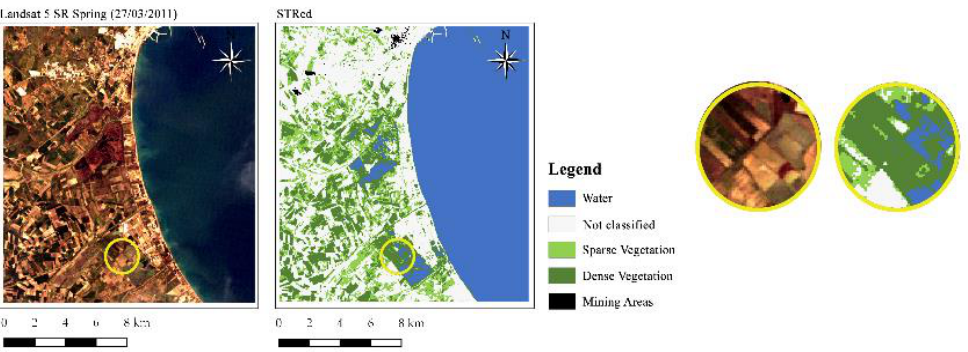
Figure 7. SwirTiRed index (STRed) classification outcome for Landsat 5 (image acquired on 27 March 2011). On the right, zoomed images with some misclassifications.